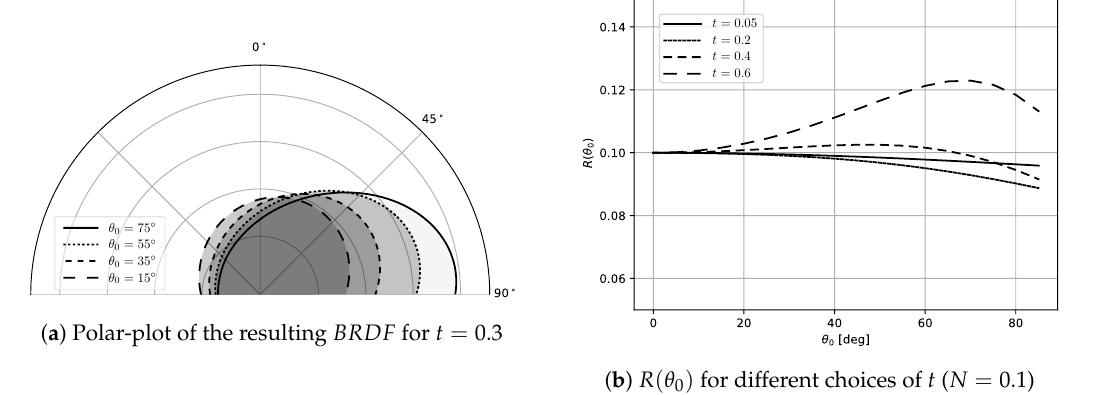
Figure 9. Illustration of the used BRDF and its associated hemispherical reflectance R ( θ 0 )